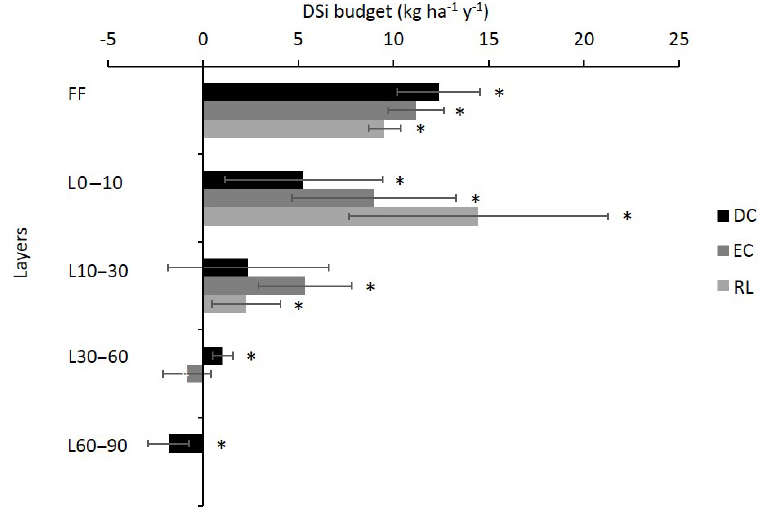
Figure 5. Mean annual DSi budget in the different layers (forest floor, FF; soil 0–10cm; soil 10–30cm; soil 30–60cm; and soil 60–90cm) for the three plots DC, EC and RL. Bars represent the SDs. Positive and negative values represent the production and immobilization of DSi in the given layer, respectively. Bars with an asterisk are significantly different from 0, according to a Mann–Whitney U test at the threshold P value level of